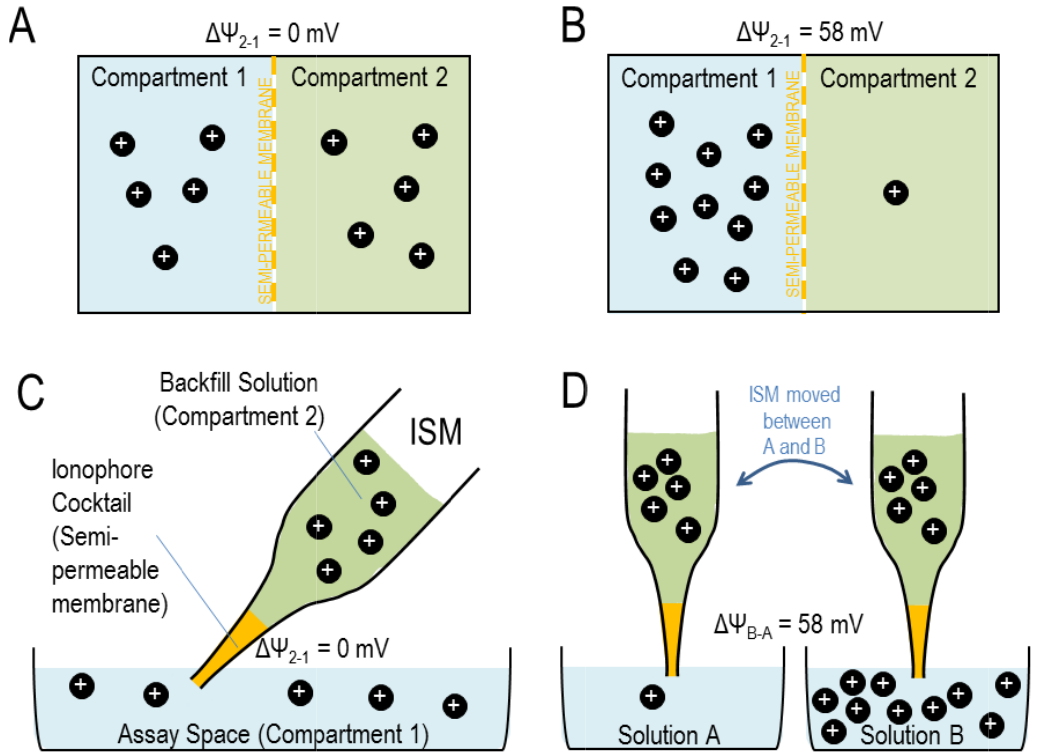
Sensors 201 Figure semi-p